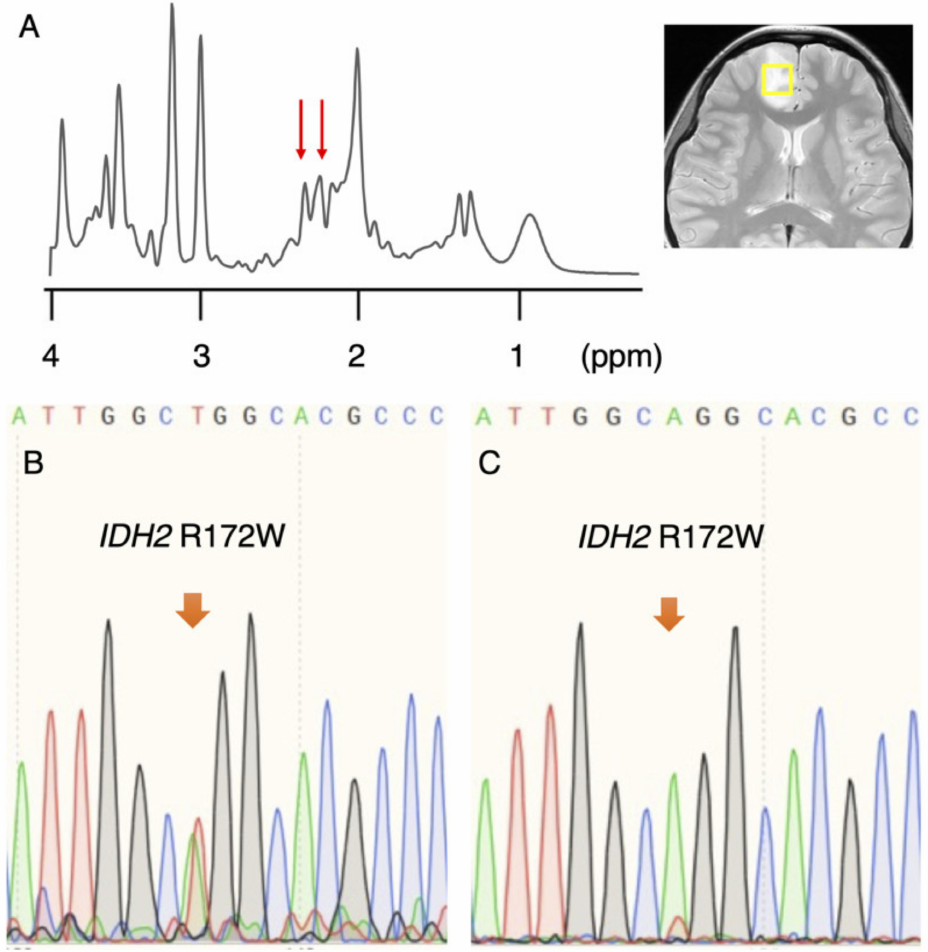
Figure 1. Rare IDH2 mutation diagnosed at relapse. ( A ) Single voxel MRS (SVMRS) spectra showing small peaks (red arrows) at a chemical shift of approximately 2.25 ppm reflect the presence of 2-hydroxyglutarate (2HG). 2HG was quantified as 6.820 mM. ( B ) Obvious IDH2 R172W mutation was detected at relapse. ( C ) Reassessment of IDH2 mutation in the initial tumor revealed a small, mutant